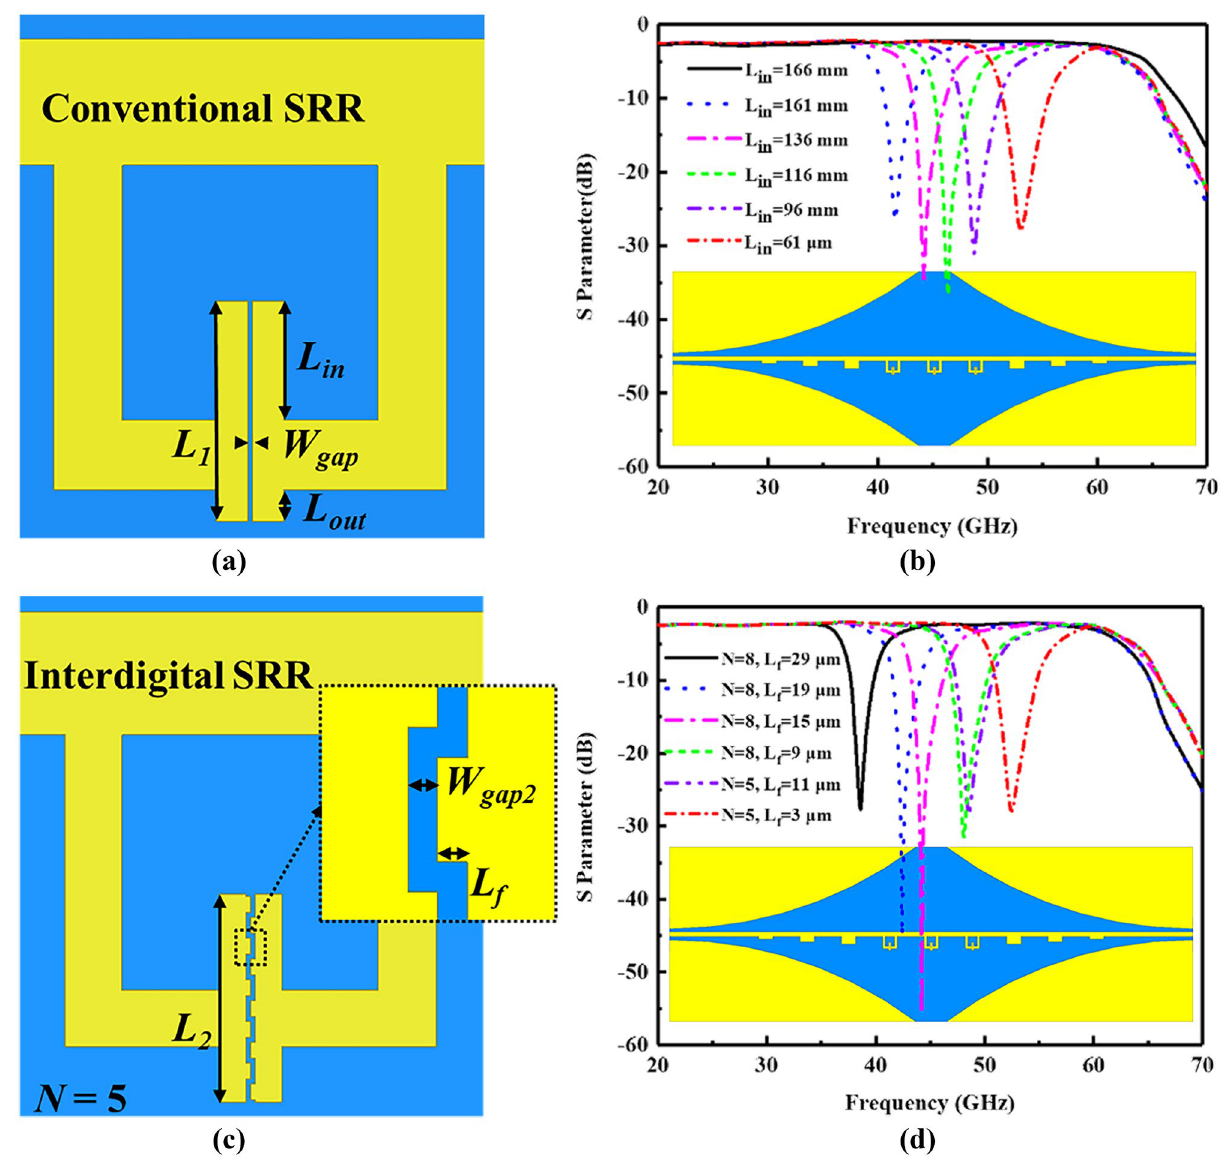
Figure 1. ( a ) Conventional SRR with parallel gap ( L 1 = 135 μm, W gap = 3 μm). ( b ) Resonant response of conventional SRR based spoof SPP device (as the inset depicted). ( c ) Interdigital SRR ( L 2 = 135 μm, W gap2 = 3 μm, L f = 3 μm, N = 5) and zoom-in view of the interdigital gap. ( d ) Resonant response of interdigital SRR based spoof SPP device (as the inset